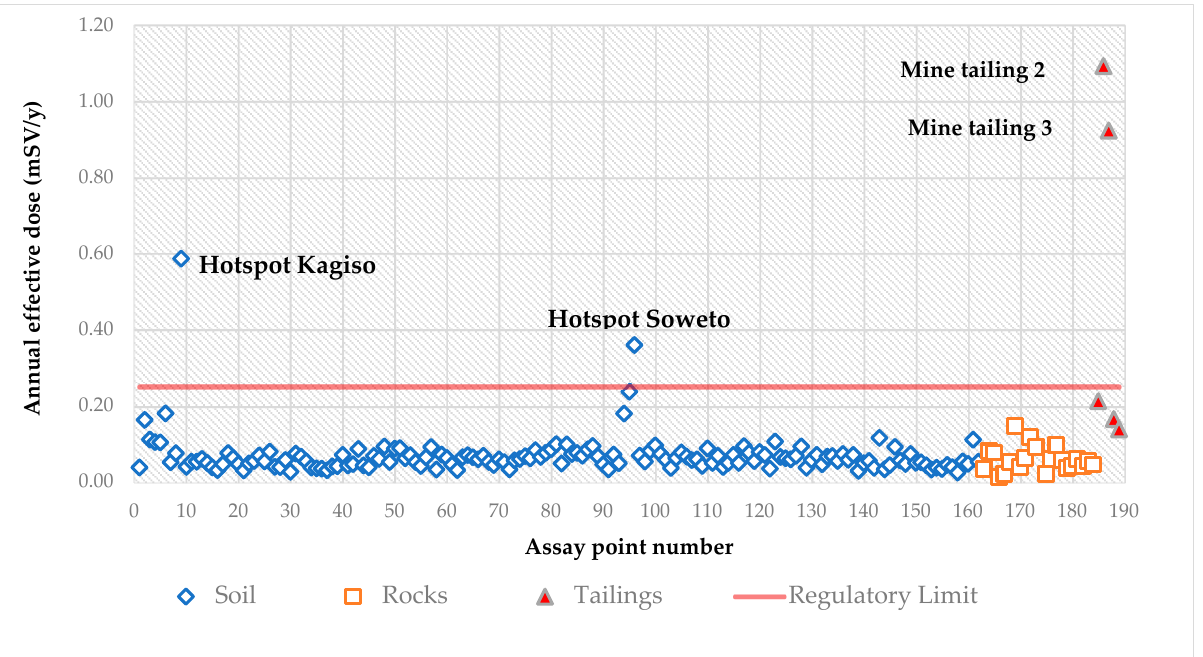
Figure 11. Annual effective dose received in the study area compared with the regulatory limit of 0.25 mSv/y.